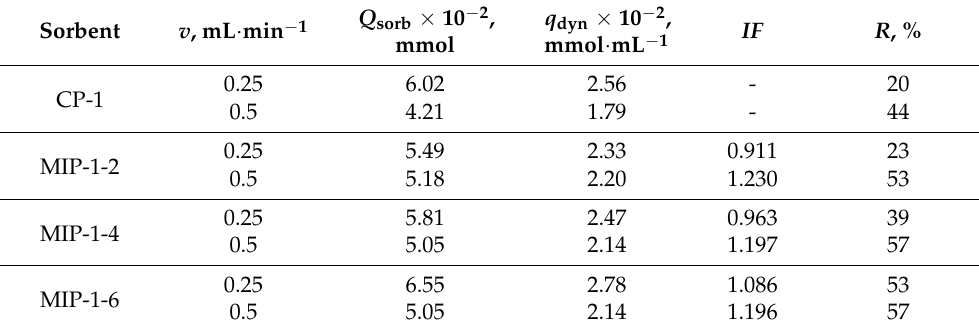
Table 7. The influence of the flow rate of the cholesterol solution on characteristics of the dynamic sorption of cholesterol, H = 3.0